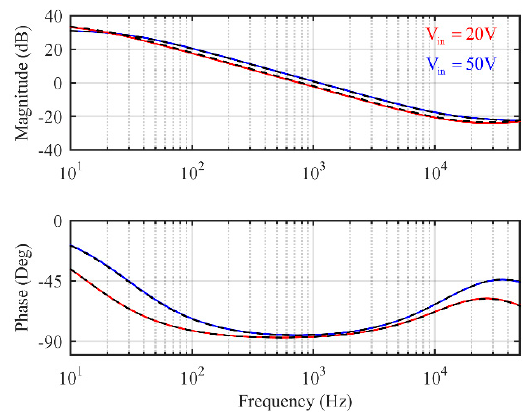
Figure 6. The black solid lines represent the frequency responses of the control-to-output transfer function predicted by the full-order model, and the dashed lines represent the corresponding frequency responses predicted by the reduced-order model at 20 V (red) and 50 V (blue).